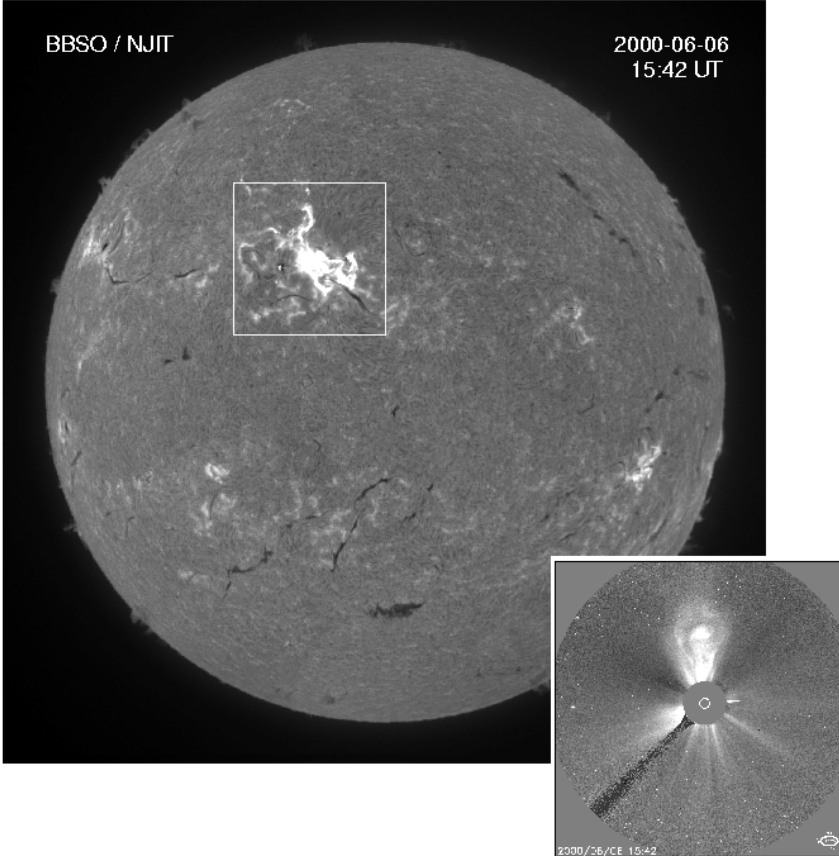
Fig. 1. Contrast enhanced full-disk H α image obtained after dark, flat- field, and limb darkening correction. The image was recorded with BBSO’s 15cm Singer telescope on 6 June 2000 at 15:42UT during the eruption of an X2.3 flare in NOAA 9026. The flare, whose position is marked by the white box, started at 14:48UT and was as- sociated with a halo CME and a se- vere magnetic storm. The inset in the lower right corner, shows the associated CME in a Large Angle and Spectro- metric Coronagraph (LASCO) C3 im- age recorded at the same